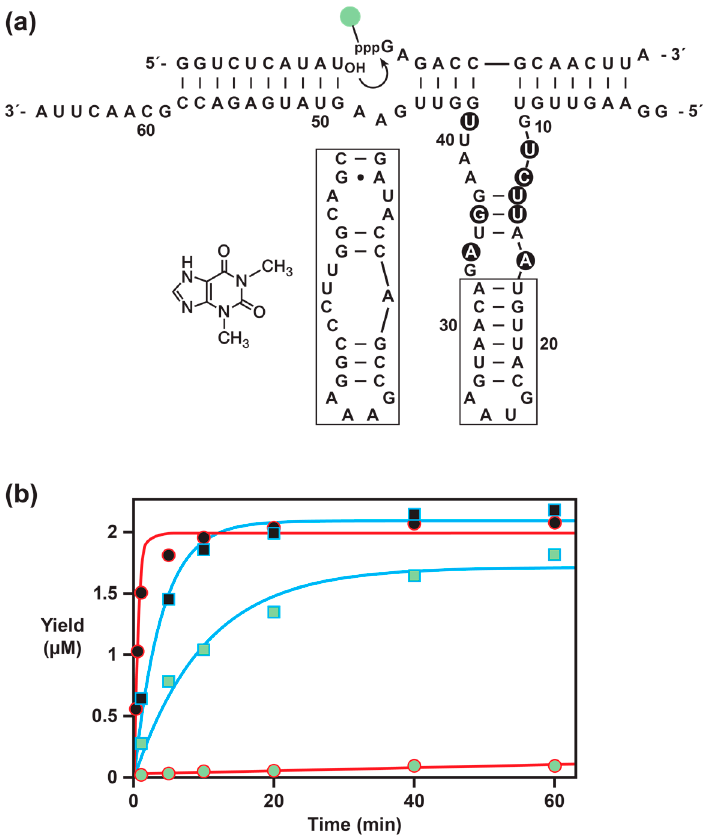
Figure 2. Composition and catalytic activity of the fluorophore-accommodating RNA enzyme. ( a ) Sequence and secondary structure of the selected enzyme, with mutations relative to the starting enzyme highlighted by black circles. The distal portion of the central stem-loop (boxed) can be replaced by an aptamer domain that binds its corresponding ligand. Shown at the left is the theophylline aptamer [12] and the chemical structure of theophylline; ( b ) Catalytic activity of the starting (red circles) and selected (blue squares) RNA enzymes with either unmodified substrate B (black symbols) or TMR-B (green symbols). Values for k obs were obtained by fitting the data to the equation: yield = a × (1 − e − b t ), where a is the maximum extent and b is the observed rate. The rate of reaction of the starting enzyme with TMR-B was determined by a linear fit of the data.